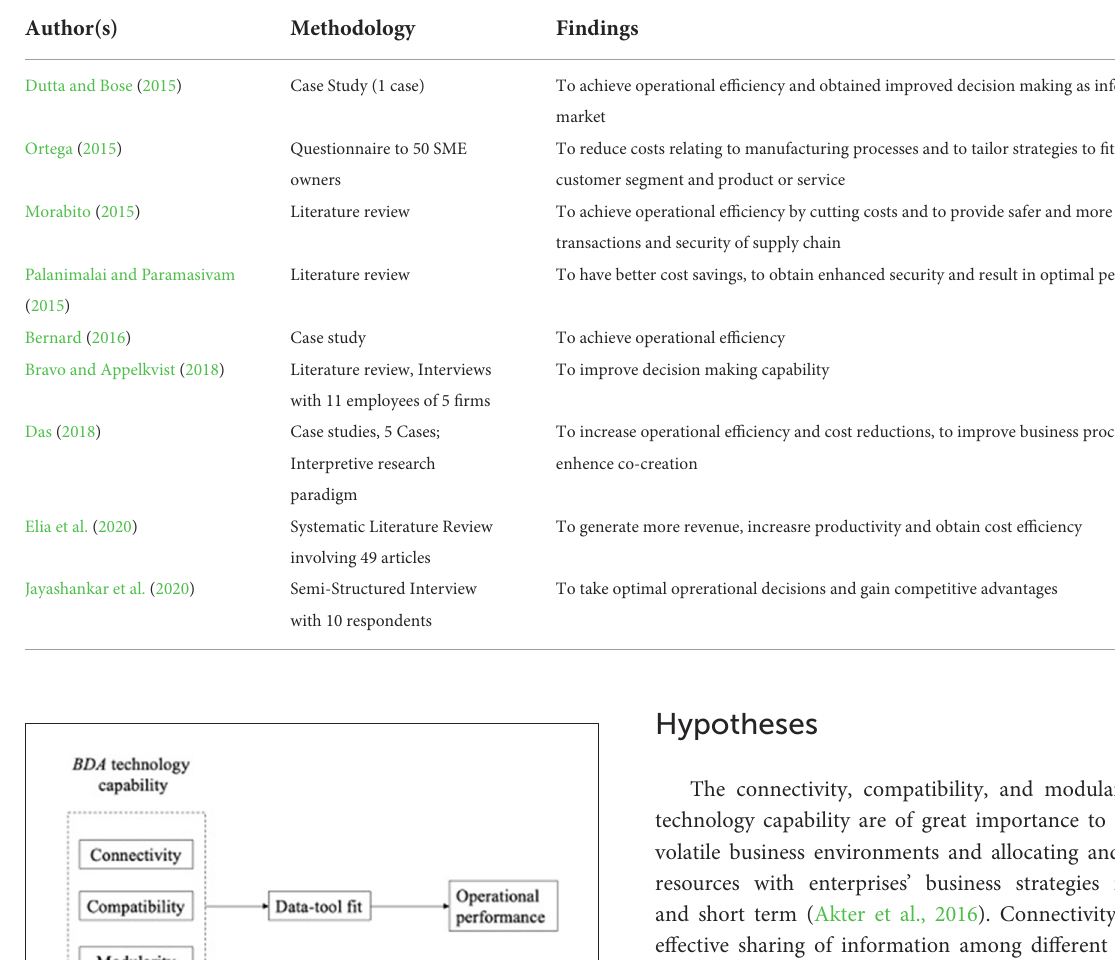
TABLE 1 Summary of literature on BDA related to enterprise operational performance.